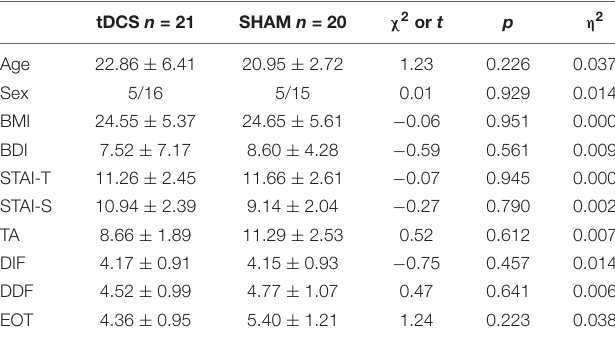
TABLE 1 | Psychological and sociodemographic